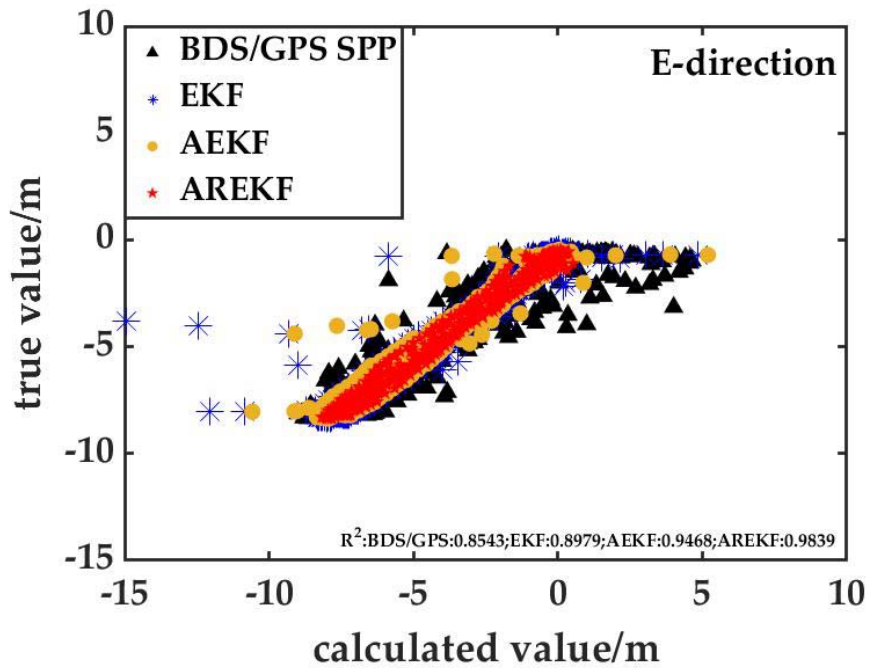
Figure 10. Correlation analysis between positioning results and reference values of each positioning scheme in E-direction.